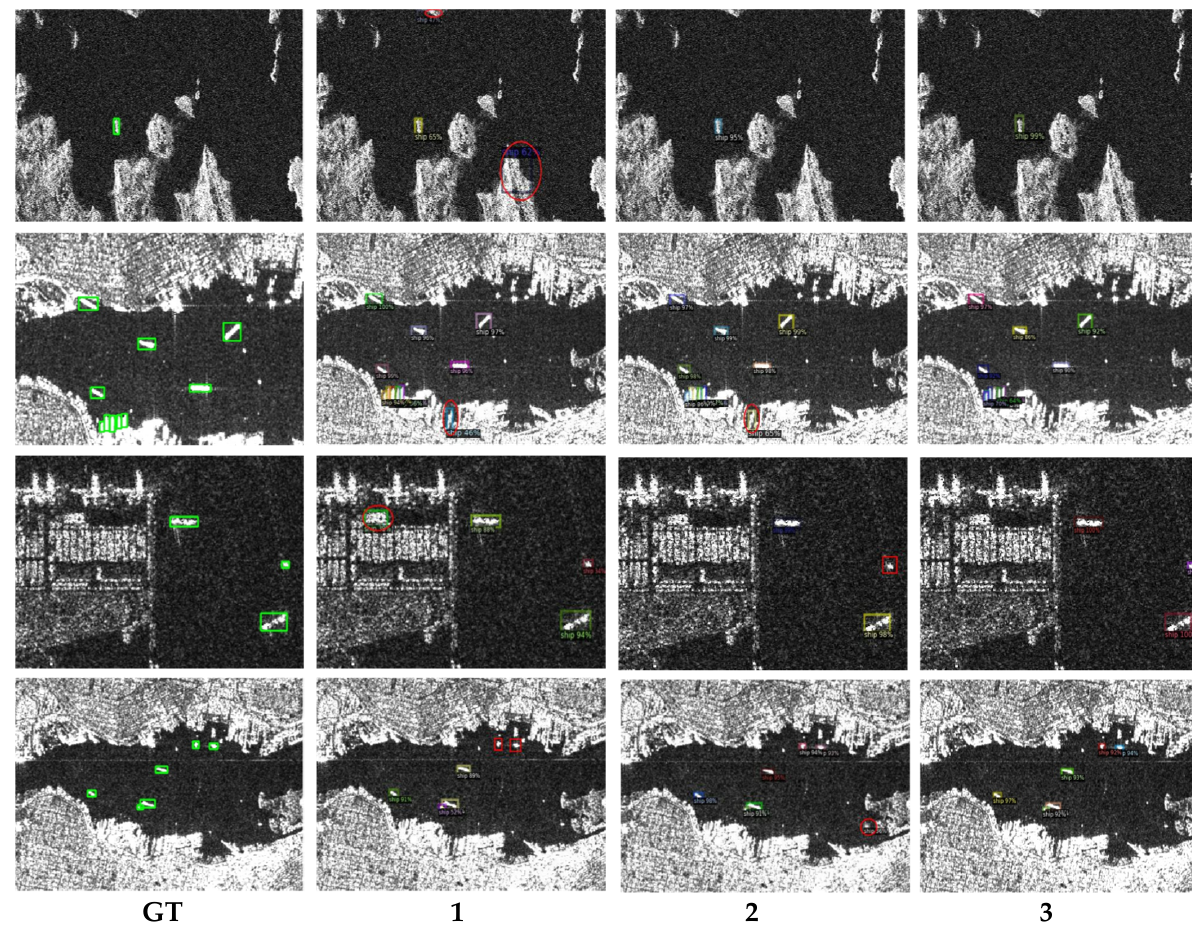
Figure 9. Ablation experiments. Note: A red circle indicates a target that is falsely detected by the